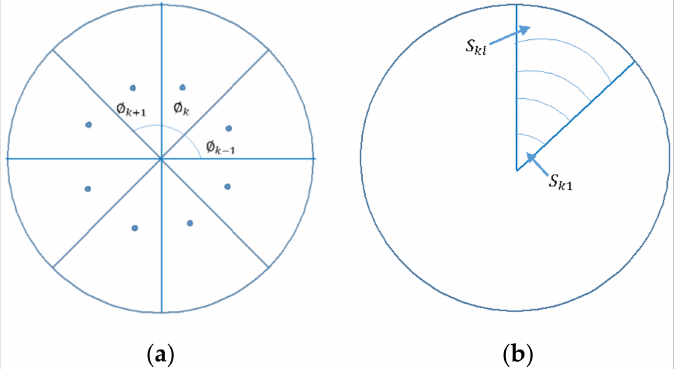
Figure 3. Partitioning the network into slices and sectors. ( a ) Slices. ( b )